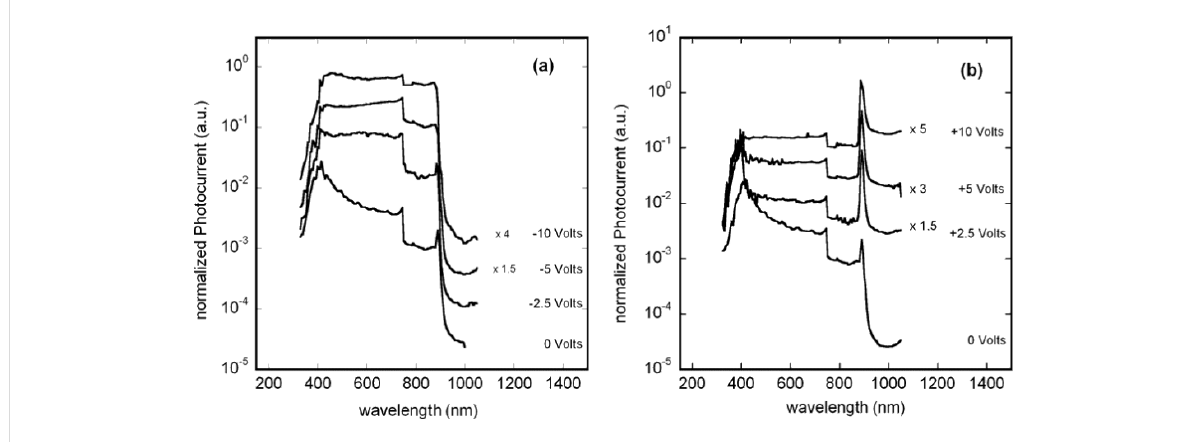
Figure 8: Normalized photocurrent spectra measured at: (a) negative voltages, (b) positive voltages applied to the ITO top contact with respect to the bottom Ti/Au contact. For the sake of clarity, some spectra were shifted up in the plots multiplying them by a factor, as indicated in the figure. The step shown in all the spectra at 750 nm is due to the change of the gratings of the monochromator.